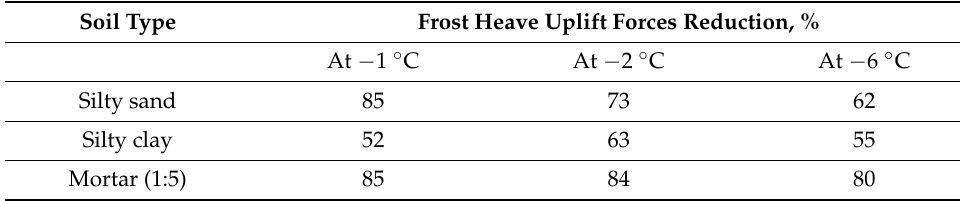
Table 4. Reduction (%) of frost heave uplift forces under increasing temperatures.